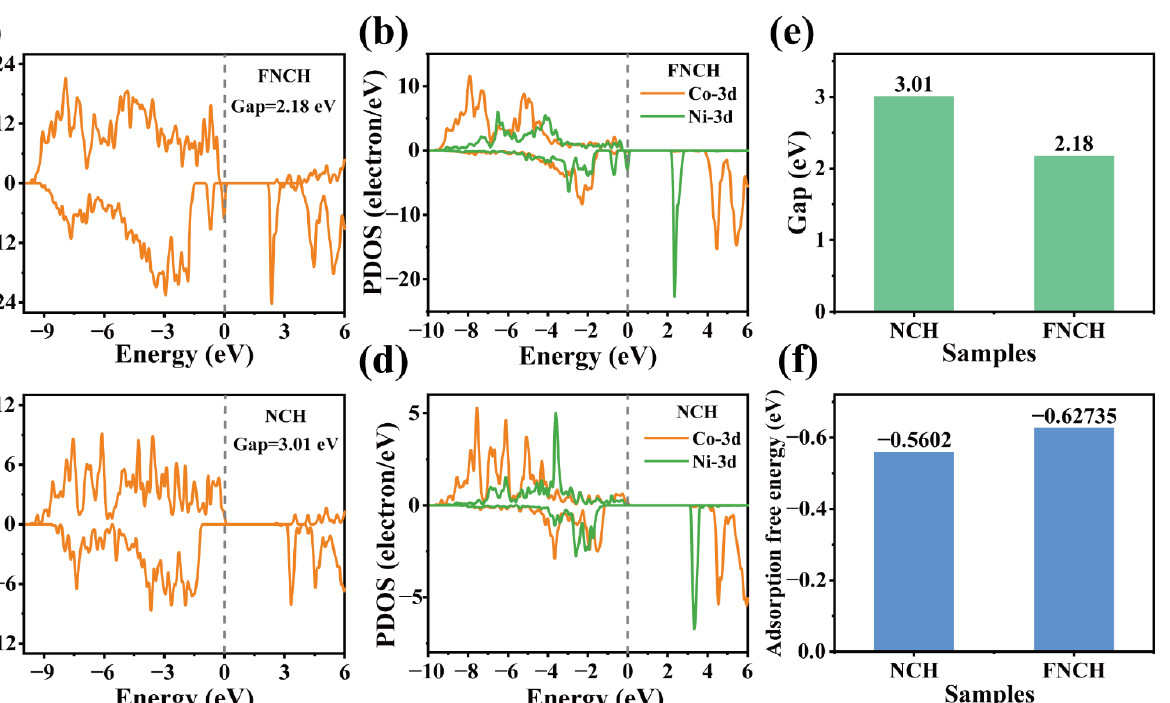
rate increases from 2 to 50 mV s −1 , suggesting low polarization and fast charge transfer.